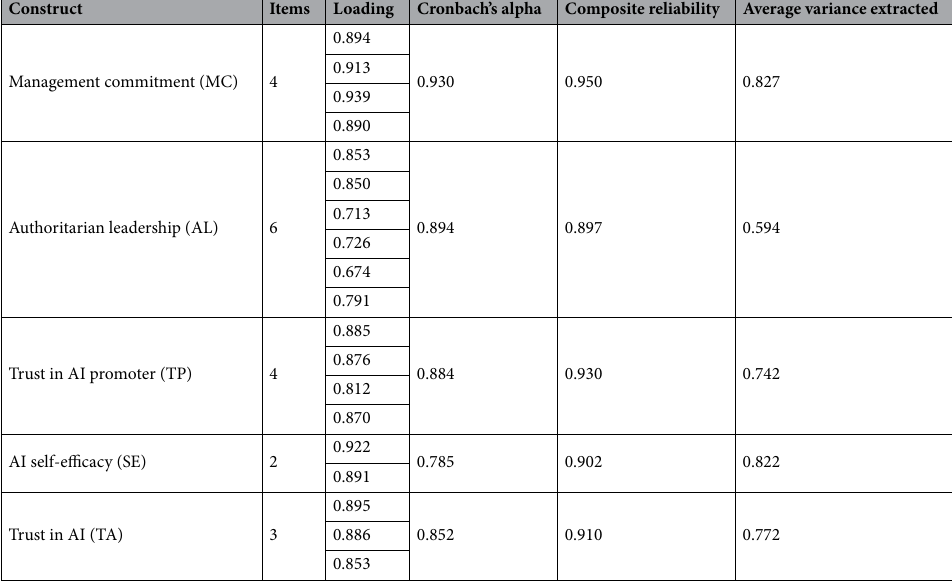
Table 6. Results of confirmatory factor